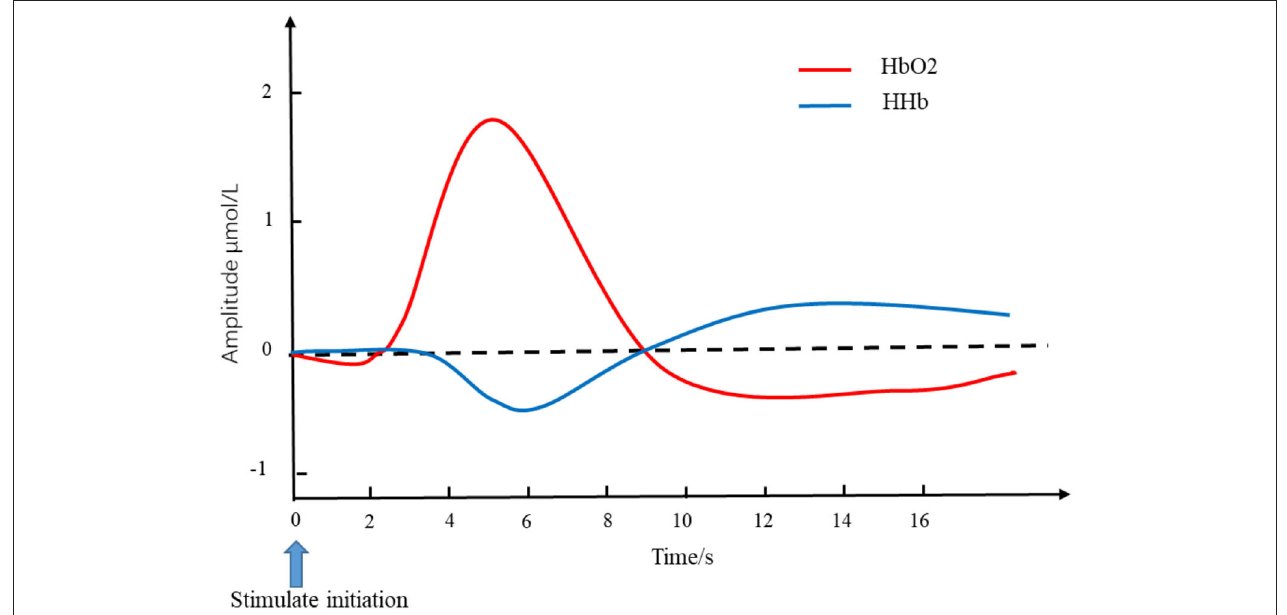
FIGURE 1 | Simulated hemodynamics in response to stimulation. The red line and blue line represent the changes of HbO 2 and HHb, respectively. The blue arrow pointing at time 0 is the initiation of stimulation. The typical changes of cerebral hemodynamic in response to the external stimulus is an increased HbO 2 accompanied by a decreased HHb. HbO 2 , oxygen hemoglobin concentration; HHb, de-oxygen hemoglobin concentration.